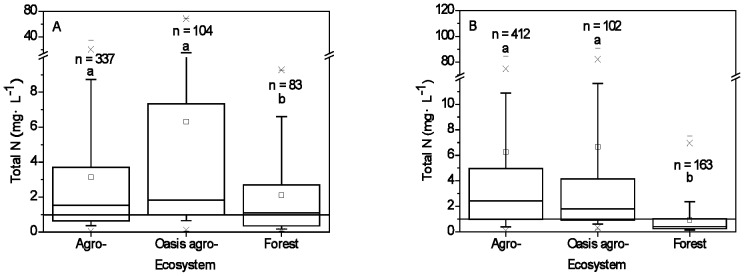
Total nitrogen concentrations in still surface water (A) and flowing surface water (B) of the agro-, oasis agro- and forest ecosystems between 2004 and 2009.Box plots illustrate the 25th, 50th, and 75th percentiles, the whiskers indicate the 10th, 90th percentiles, the “-”s indicate the maximum and minimum percentiles, the “×”s indicate the 1th and 99th percentiles, the “□”s indicate the mean values. Box plots labeled with different letters (a, b) indicate that differences in median values among the three ecosystem types are significant at p < 0.05. “—” illustrate the Class III guideline of 1.0 mg·L−1 for total nitrogen according to the national quality standards for surface waters of China.